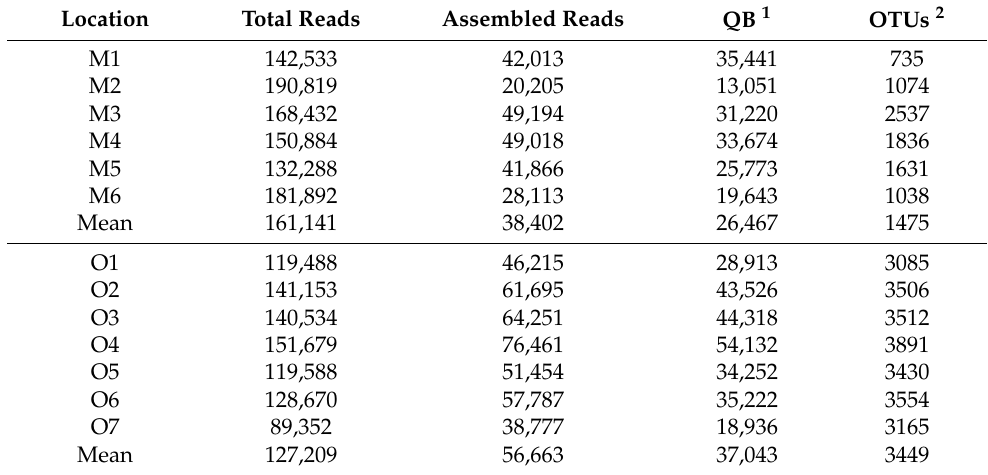
Table 2. Fecal samples sequences obtained from two populations of Mexican wolves (Canis lupus baileyi) in Michilia (M, 23 ◦ N) and Ocotal (O, 19 ◦ N),